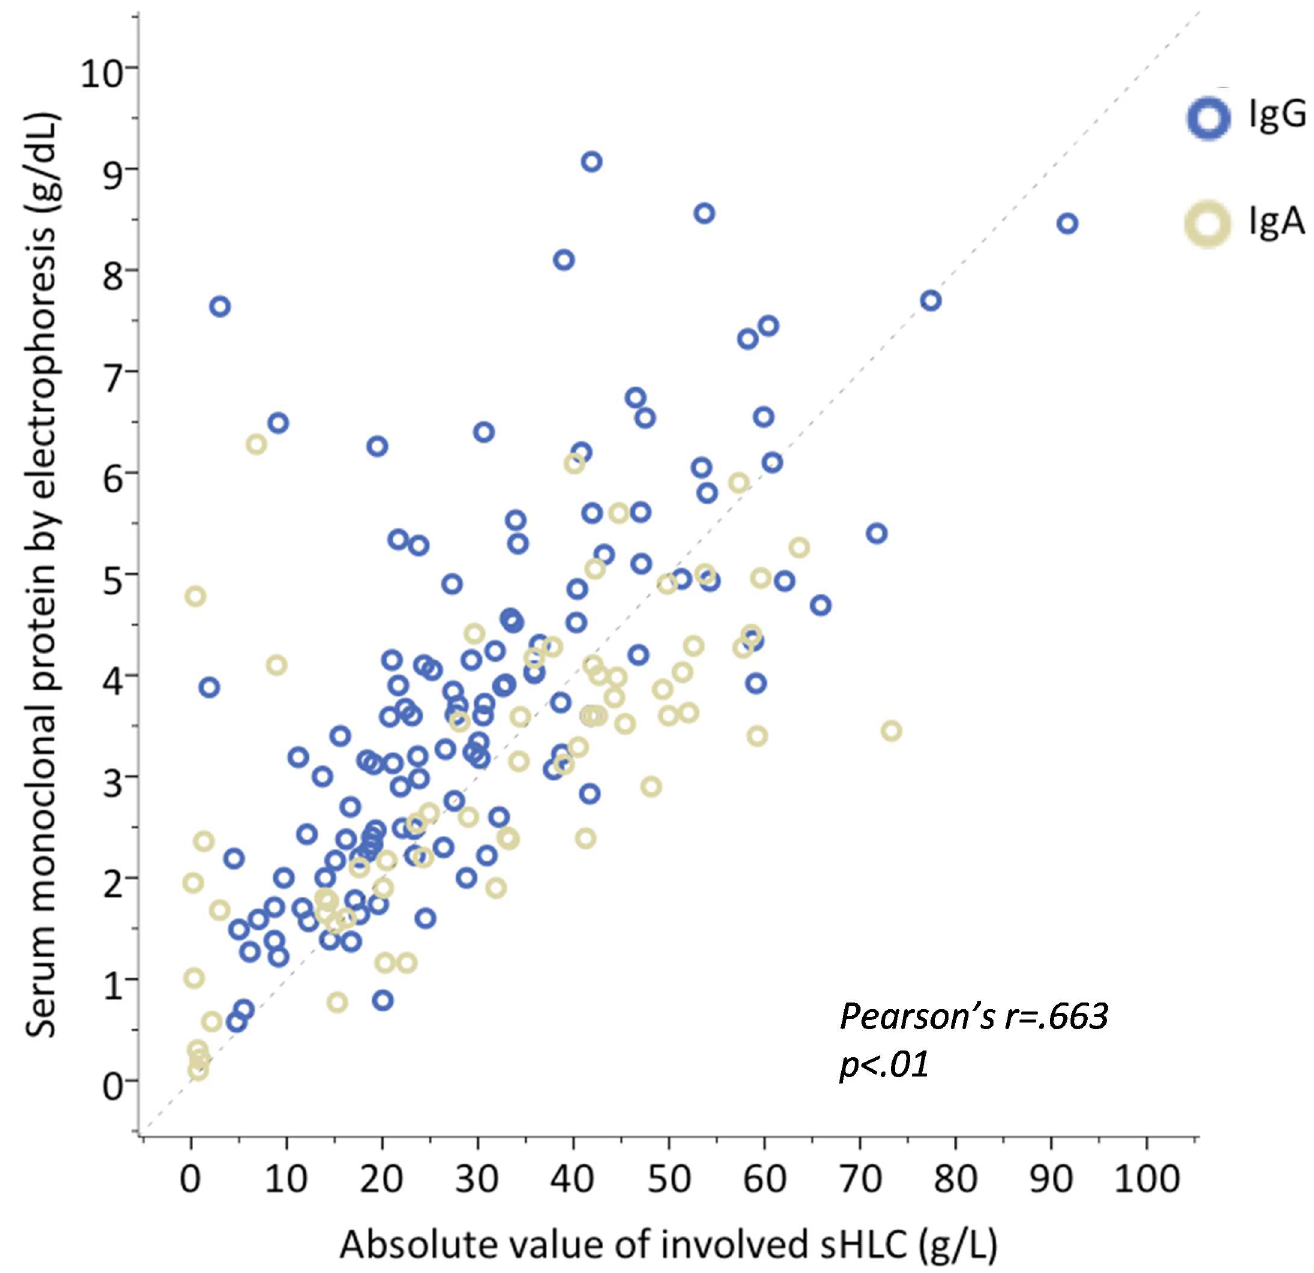
Fig 3. Absolute values of monoclonal proteins (MPs) measured with serum protein electrophoresis (sPE) vs. absolute values of the involved heavy-light chains (isHLC). Correlation analysis shows agreement between the absolute values of IgA (blue, r = 0.65 and IgG (grey, r = 0.71) MPs and isHLC measurements.